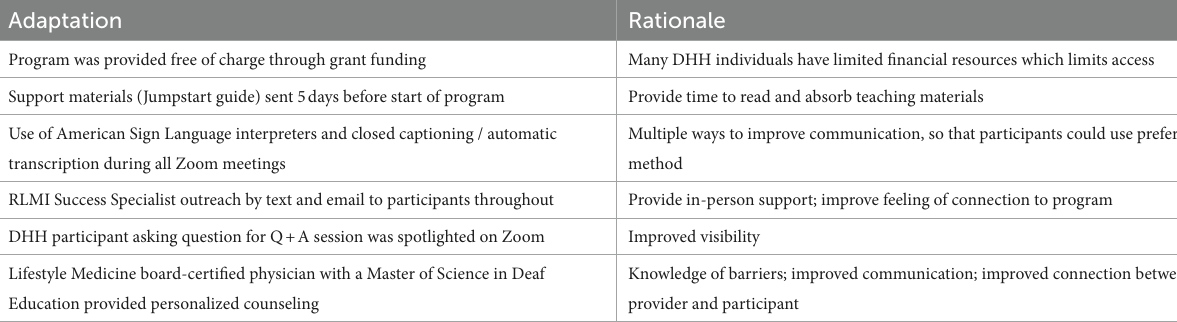
TABLE 1 Adaptations to Jumpstart program for a DHH cohort.